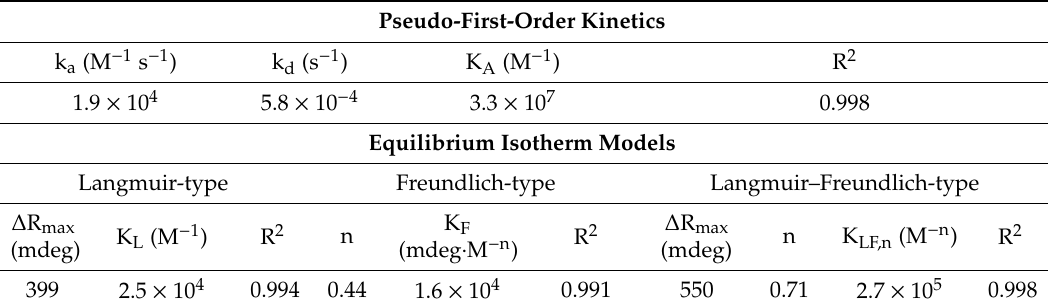
Table 2. Estimated parameters of kinetic law and sorption isotherm relationships in the case of glyphosate sorption onto CS / ZnO SPR sensors at pH 5.5 (see relationships (3) to